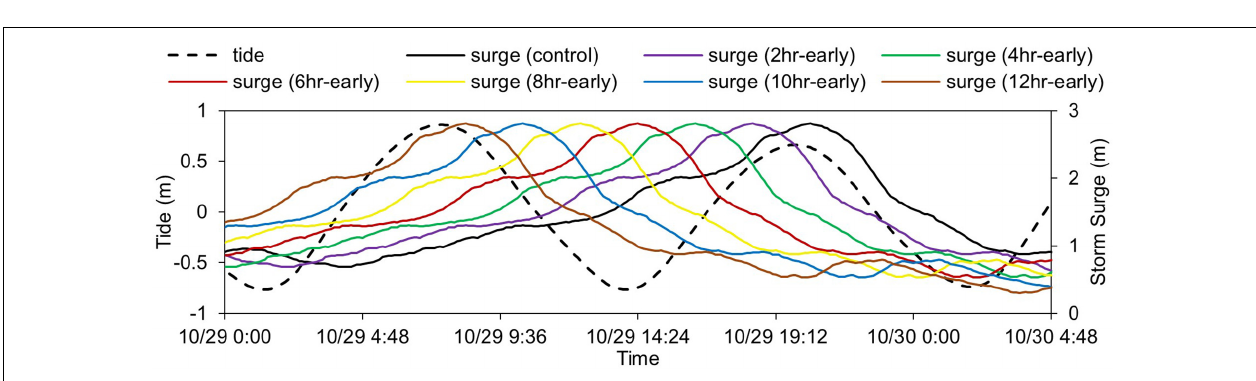
FIGURE 4 | Time series of tides and storm surge heights at different arrival times considered in the numerical